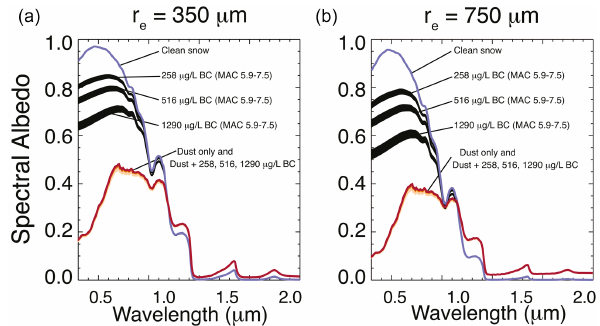
Figure 5. Modeled spectral snow albedos for the surface layer at Mera La based on dust = 9.3 g/L, M BC = 258 µgL − 1 , − 1 , − 1 with the MAC M BC × 2 = 516 µgL M BC × 5 = 1290 µgL of BC ranging between 5.9–7.5m 2 g − 1 , and assuming snow optical grain radius of (a) 350µm and (b)